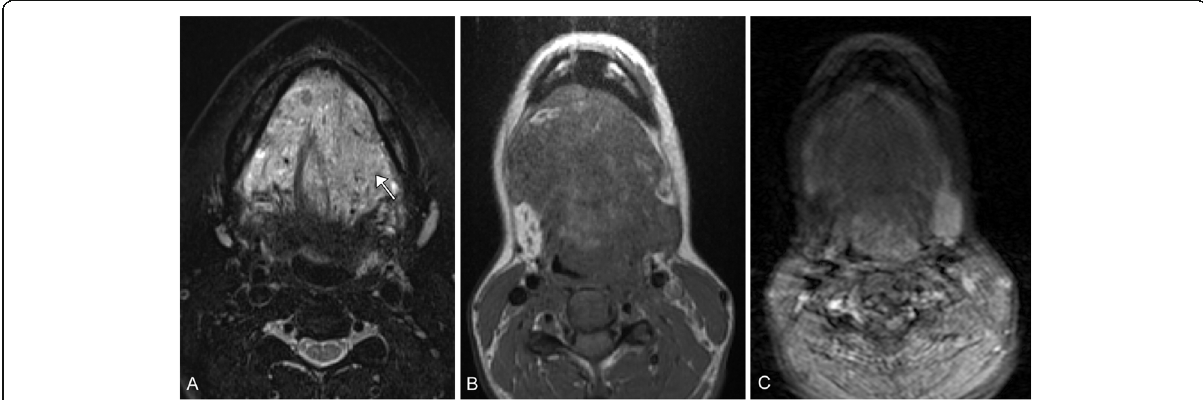
Fig. 10 Microcystic lymphatic malformation. An 11-year-old female with progressive mouth fullness. a Axial T2 fat-saturated image demonstrates a transpatial hyperintense lesion within the floor of the mouth (arrow) containing tiny cysts. b Axial T1 image demonstrates the lesion to be hypointense. c Axial T1 post-contrast image demonstrates no